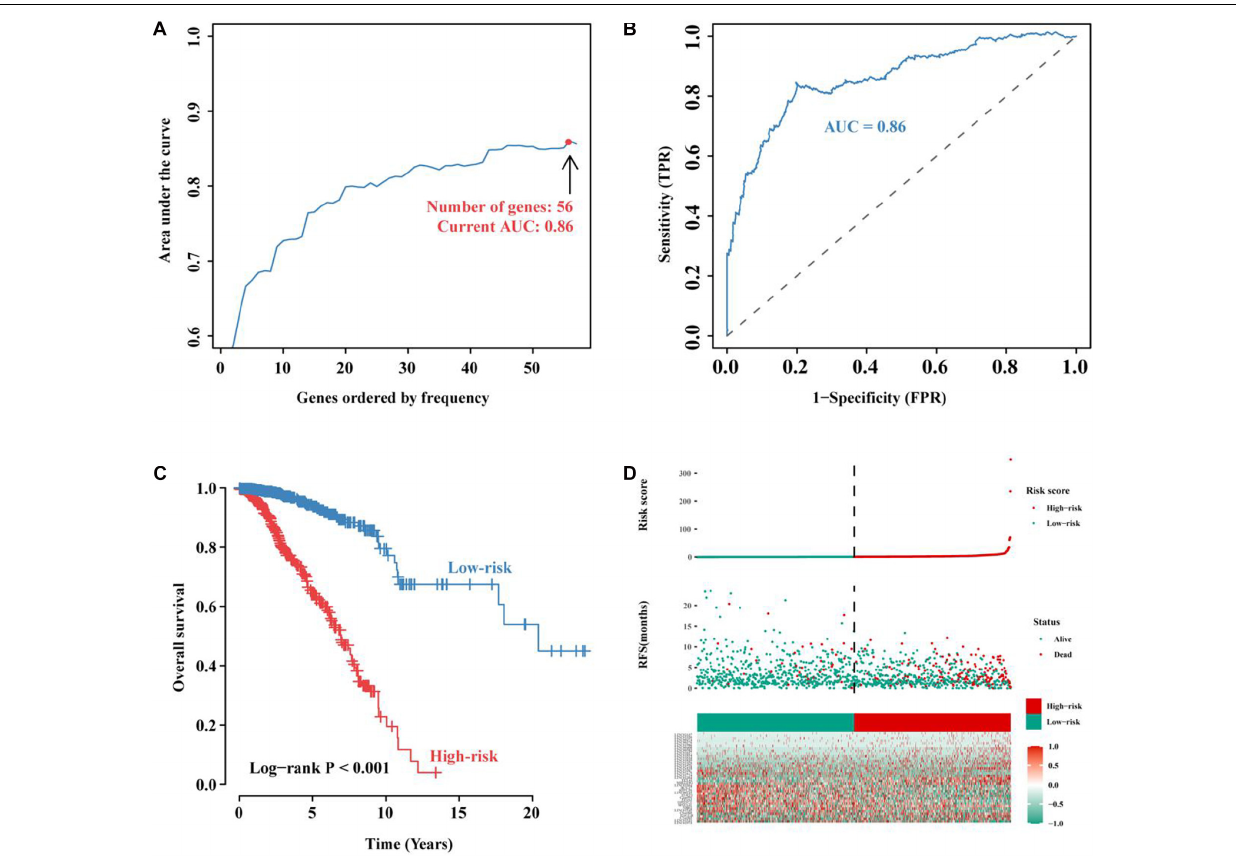
Frontiers in Genetics |